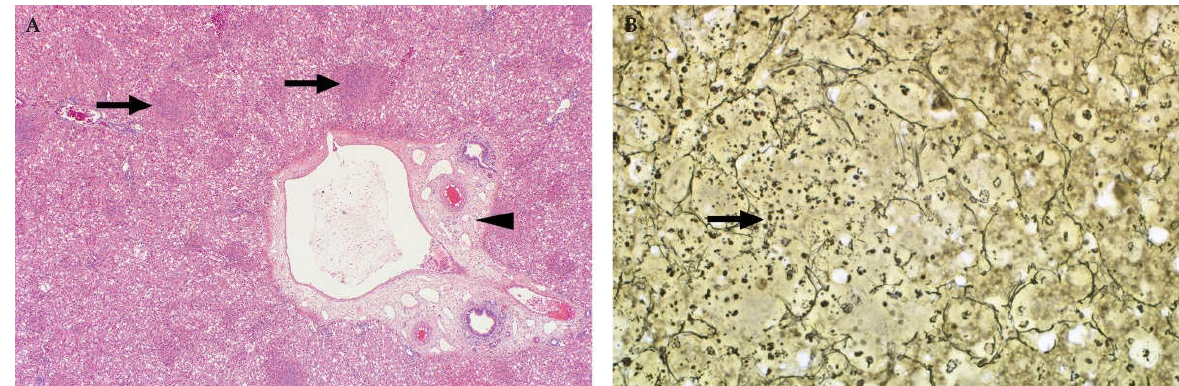
Figure 4. Histopathology of the liver in sheep foetuses naturally infected with RVFV. ( A ) Multiple foci of liquefactive hepatic necrosis (arrows), also referred to as primary foci, are present (H&E stain). There is also severe periportal oedema (arrowhead), mag 40×. ( B ) Nuclear fragments and remnants of reticulin fibres (arrow) are present in an area of liquefactive necrosis (Gordon and Sweets’ silver stain for reticular fibres with Van Gieson counterstain), mag 400×.